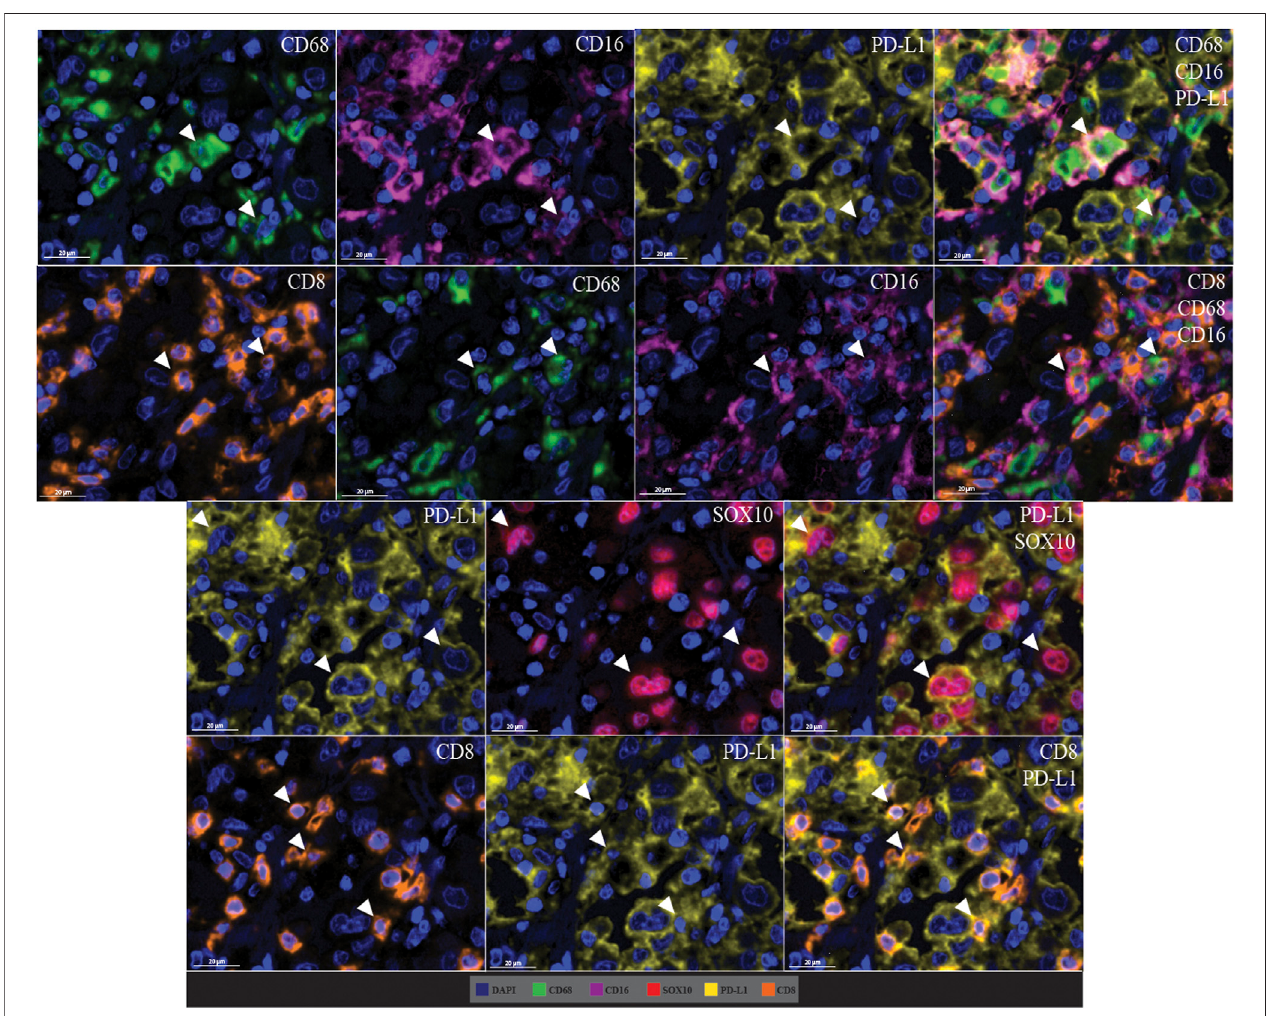
FIGURE 10 | Microphotographs of representative examples of marker co-localisation in multiplex immuno fl uorescence, showing speci fi c cell phenotypes. Composite images show the integration of markers on a single slide. White arrows indicate cell phenotypes which include PD-L1+ macrophages (CD68 positive, CD16 positive, and PD-L1 positive cells), CD8-expressing macrophages (CD68 positive, CD16 positive, and CD8 positive cells), PD-L1+ tumour cells (PD-L1 positive and SOX10 positive cells), and PD-L1+ cytotoxic T-cells (CD8 positive and PD-L1 positive cells). Scale bars are 20 µm (40×).